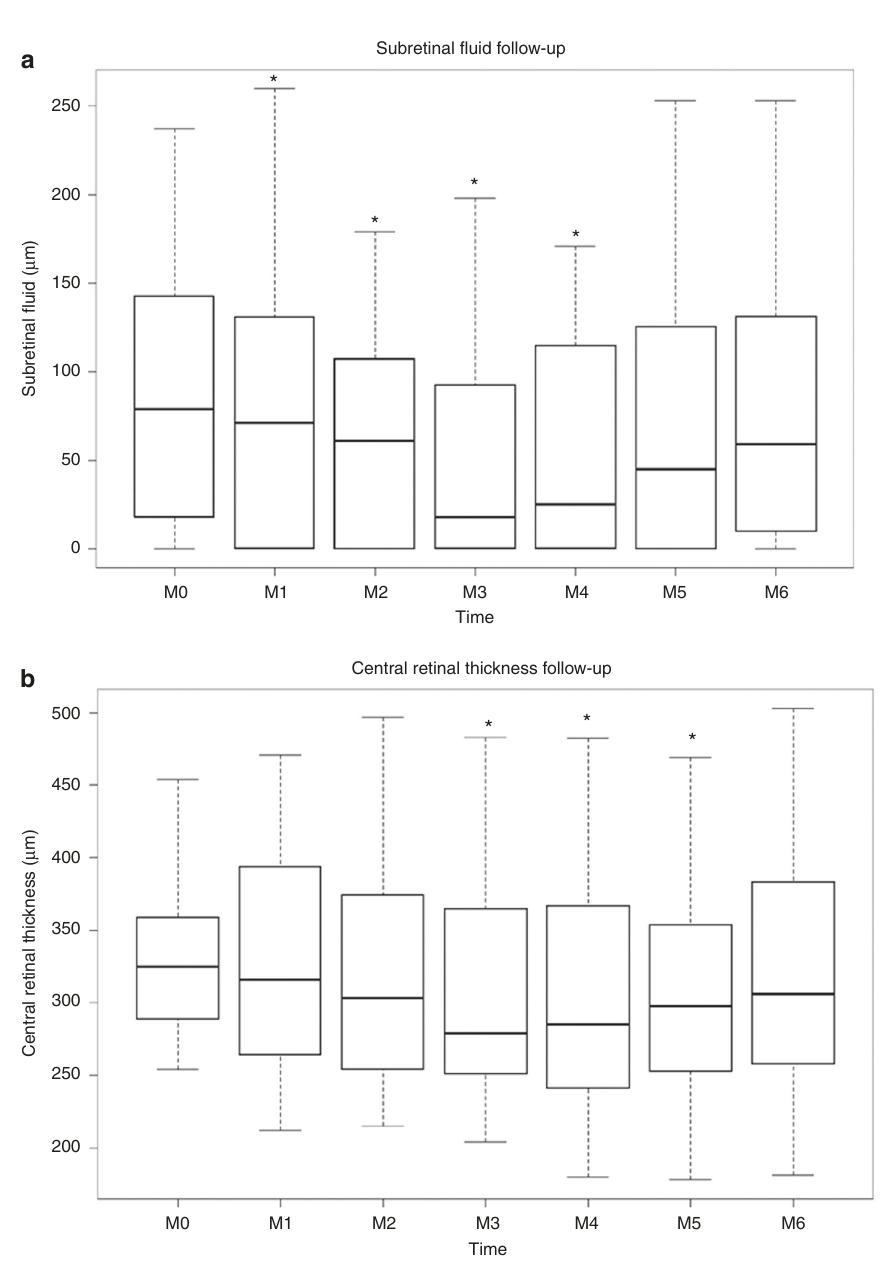
Fig. 1 Clinical results. a Relative changes in subretinal thickness (SRF, µ m) measured with Spectralis OCT during the study period, month 0 (M0) to month 6 (M6). SRF thickness is signi fi cantly reduced as compared to M0, at M1 ( p = 0.012), M2 ( p = 0.040), M3 ( p = 0.014), M4 ( p = 0.024). b Relative change in central retinal thickness (CRT, µ m) automatic values with Spectralis OCT during the study period, month 0 (M0) to month 6 (M6). CRT is signi fi cantly reduced as compared to M0, at M3 ( p = 0.011), M4 ( p = 0.007), and M5 ( p = 0.028). At each time point (Month, M), the data have been summarized using box and whisker plots, the upper and lower 95% CIs (con fi dence interval) are marked with the whiskers, the box represents the interquartile range, and the median is represented by the bold horizontal line bisecting the box. Paired Wilcoxon signed-rank tests were used. * p < anti-edematous effect unrelated to the CNV, as previously subcutaneous injections from day 0 to day 13) was as ef fi cient as described in other retinal conditions 23,26 . To test the anti- intravitreal anti-VEGF injection (5 µl at 1.5 µg/µl, at day 0) in angiogenic potential of MRA on CNV, we used an experimental reducing choroidal vascular leakage assessed by angiographic model induced by laser photocoagulation in rodents, a recognized score and decreasing the volume of the CNV lesions measured on model for nAMD 33 . The argon laser induces a rupture of the choroid fl at-mounts (Fig. 2a). Co-administration of anti-VEGF Bruch ’ s membrane, which separates the RPE from the choroidal and spironolactone showed an additive effect on neovascular vasculature, leading to the growth of neovessels from the choroid permeability observed on FA as compared to anti-VEGF alone toward the retina in about 2 weeks. The permeability and size of (Fig. 2a). Systemic spironolactone inhibited the accumulation of CNV were assessed in vivo by fl uorescein angiography (FA) at allograft in fl ammatory factor 1 (IBA1)-positive macrophages/ day 14 and at day 16 after sacri fi ce by ex vivo staining with FITC- microglia in the laser burn area (Supplementary Fig. 5a) and isolectin on choroid fl at-mounts. Spironolactone (25 mg/kg/day, reduced the expression of in fl ammatory cytokines (monocyte